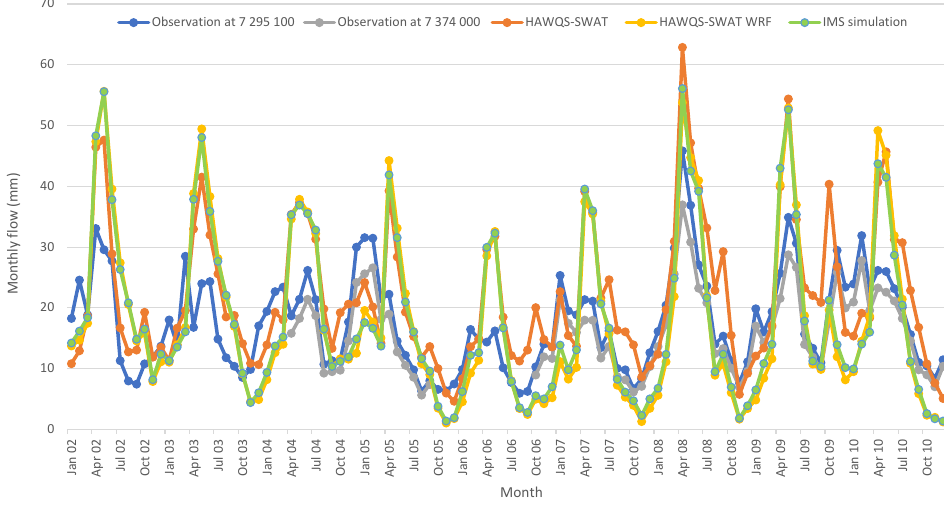
Figure 5. Monthly streamflow evaluation at USGS